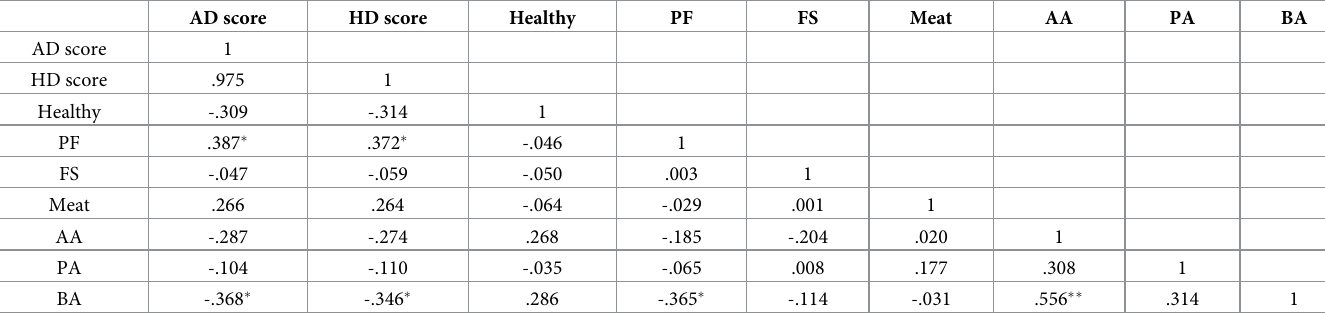
Table 7. Correlation analysis among the dietary patterns, ADHD scores, and the concentrations of short-chain fatty acids. AD score HD score Healthy PF FS Meat AA PA BA AD score 1 HD score .975 1 Healthy -.309 -.314 1 PF .387 � .372 � FS -.047 -.059 -.050 Meat .266 .264 -.064 -.029 .001 1 AA -.287 -.274 .268 -.185 PA -.104